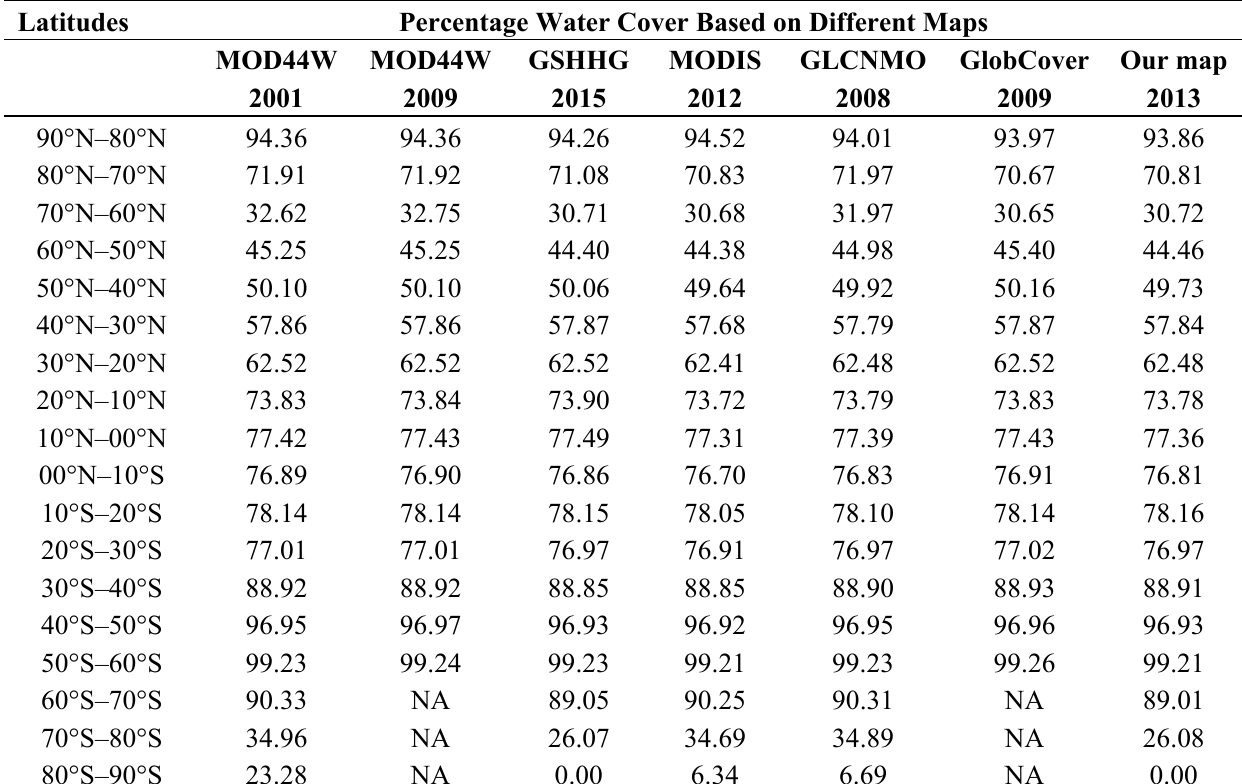
Table 1. Estimates of percentage water cover by different maps at every interval of 10° latitudes.